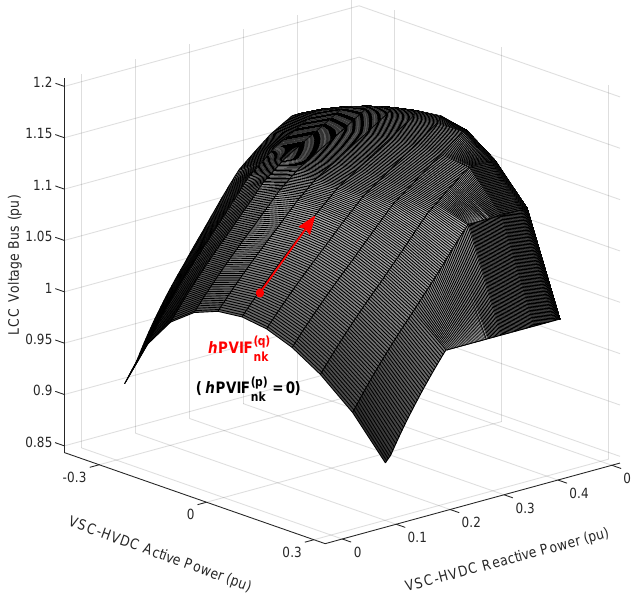
Figure 8. Three- dimensional view of the relation between (cid:126) S k and V n